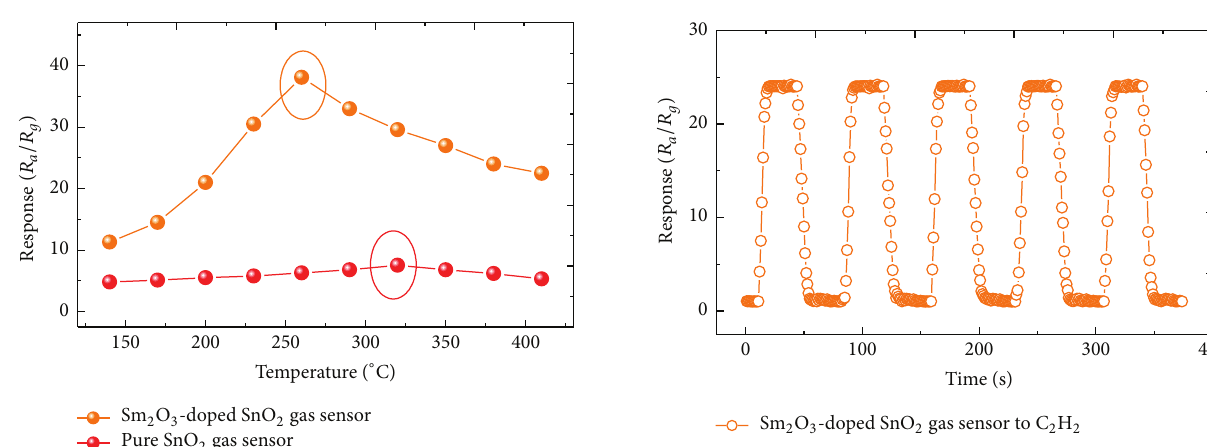
Figure 7: Gas responses of the sensors to 50 𝜇 L/L of C 2 H 2 at various working temperature.